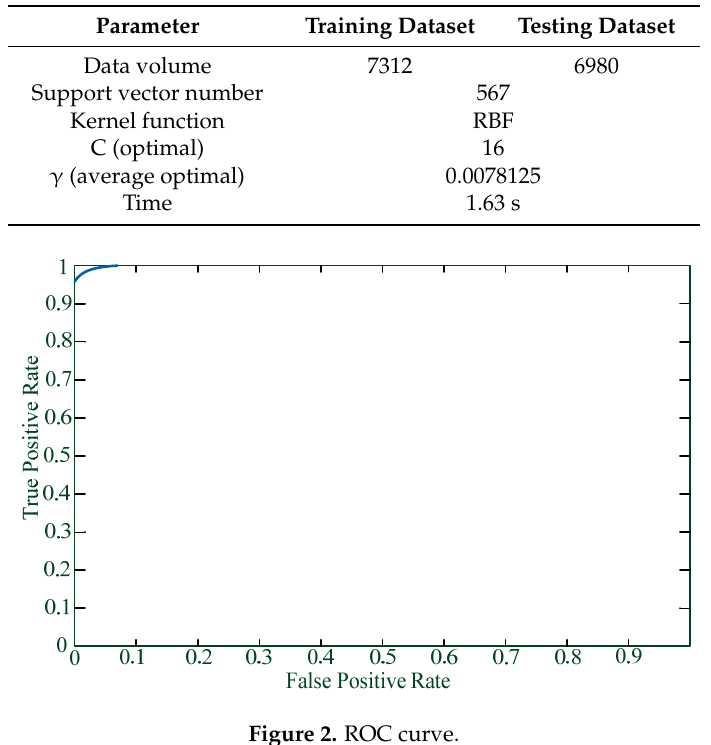
Table 1. Testing Results.